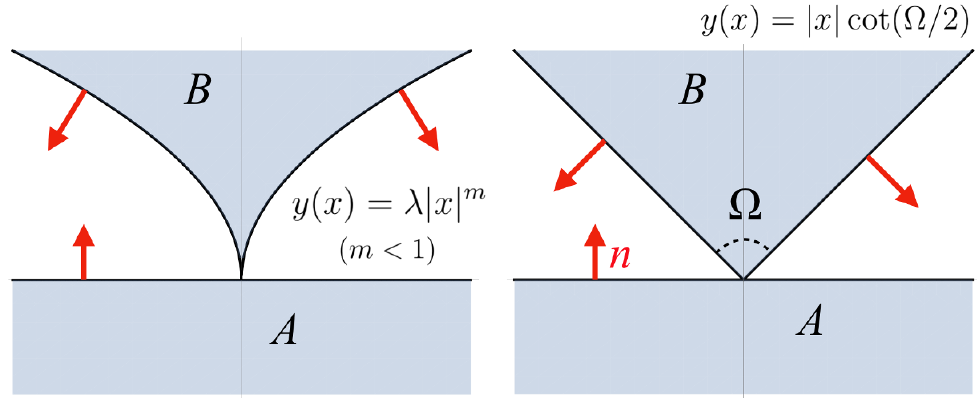
Figure 5 . We show two entangling regions on a time slice of a three-dimensional theory corre- sponding, respectively, to a half plane and a region characterized by a corner de(cid:12)ned by the regions y ( x ) (cid:21) (cid:21) j x j m , (cid:21) (cid:21) 0 (left) and y ( x ) (cid:21) j x j cot((cid:10) = 2) (right). The red arrows correspond to normal vectors to the entangling surfaces. For the straight corner, the mutual information I ( A; B ) diverges logarithmically, eq. (4.3). Whenever m < 1, however, the mutual information remains (cid:12)nite even when A and B touch each other at a